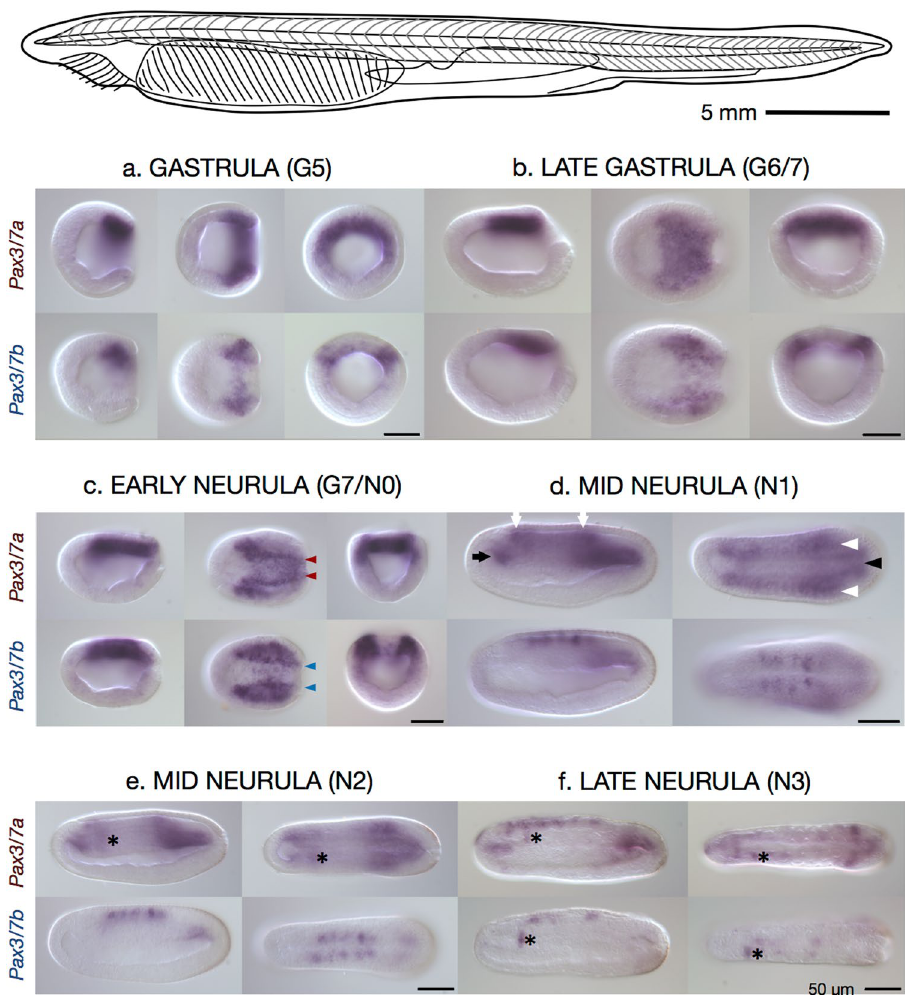
Figure 3. Expression of Pax3/7a and Pax3/7b in a B . lanceolatum early developmental time course. Top: Illustrative line drawing of adult B . lanceolatum . Scale bar ≈ 5 mm. Below: Whole mount in situ hybridisation images of Pax3/7a -specific probe (top row of each block) and Pax3/7b -specific probe (bottom row of each block) in B . lanceolatum embryos. Views are presented, in left-to-right order: lateral, dorsal, and blastoporal (gastrula and early neurula only). Lateral and dorsal views are oriented with the anterior to the left. (a) Gastrula, G5, 10 hours post fertilisation (hpf). (b) Late gastrula, G6/7, 12 hpf. (c) Early neurula, G7/N0, 14 hpf. ( d , e ) Mid neurulae: N1, 16 hpf and N2, 21 hpf. (f) Late neurula, N3, 24 hpf. Domains of expression are marked throughout as follows: coloured arrowheads — differentially patterned neural plate border expression; black arrow — expression in the anterior mesodermal tissue; white arrows — in the anterior end and posterior of the neural tube; white arrowheads — in the postero-lateral somitic tissue; black arrowhead — in the postero-medial notochord tissue; asterisk — (placed immediately posteriorly to) the sinistral domain of expression found in both paralogues and in A . lucayanum . Scale bars = 50